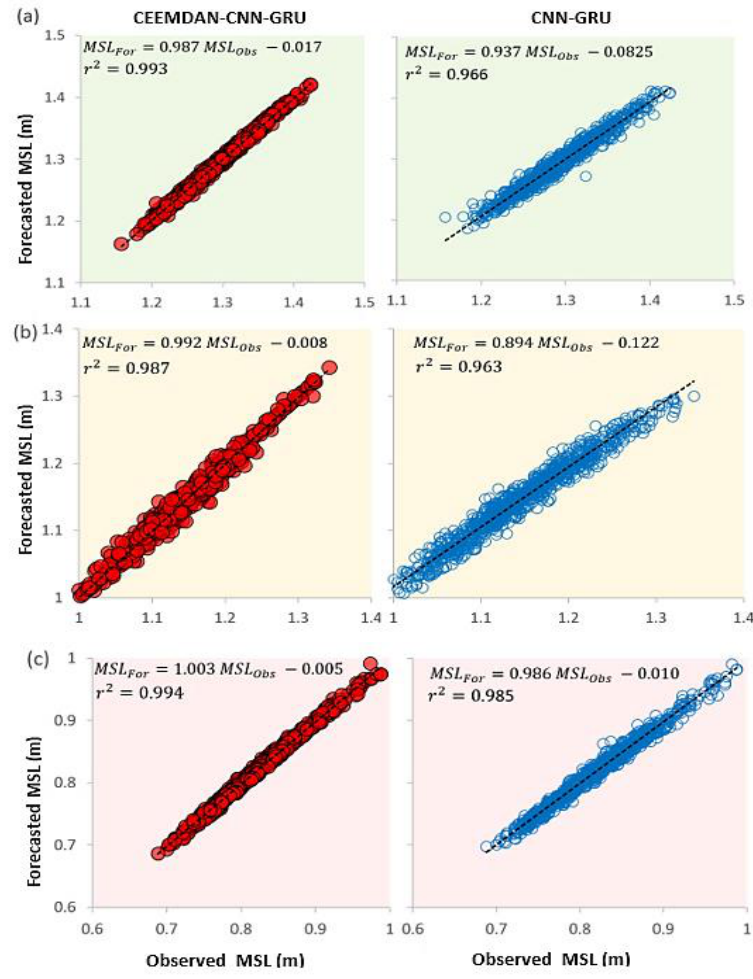
Figure 12. Scatter plot of forecasted vs. observed MSL of ( a ) Fiji Island, ( b ) Marshall Island, and ( c ) PNG using CEEMDAN-CNN-GRU and CNN-GRU model in the testing phase. A least square regression line and coefficient of determination ( r 2 ) with a linear fit equation are shown in each sub-panel. Table 4. Legates and McCabe Index results of the hybrid CEEMDAN-CNN-GRU vs. benchmark (CNN-GRU, CEEMDAN-GRU, GRU) models for three study sites.